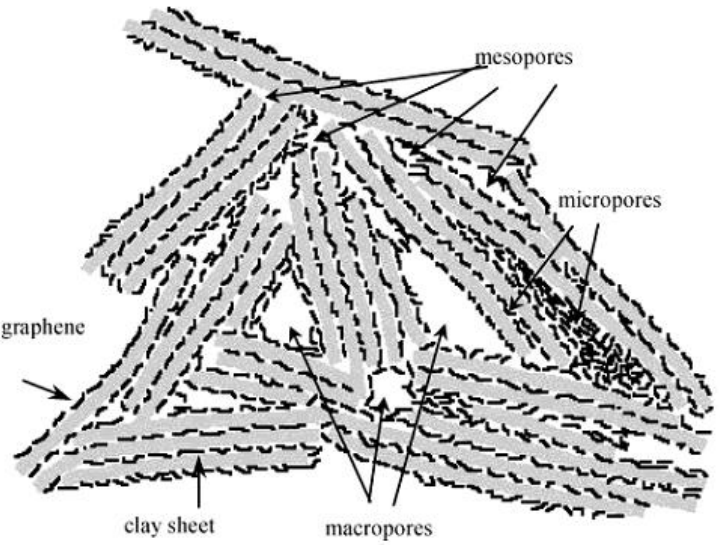
Figure 1. Schematic view of the probable architecture of a clay carbon composite (reproduced from ref. [27], copyright 2004, American Chemical Society).